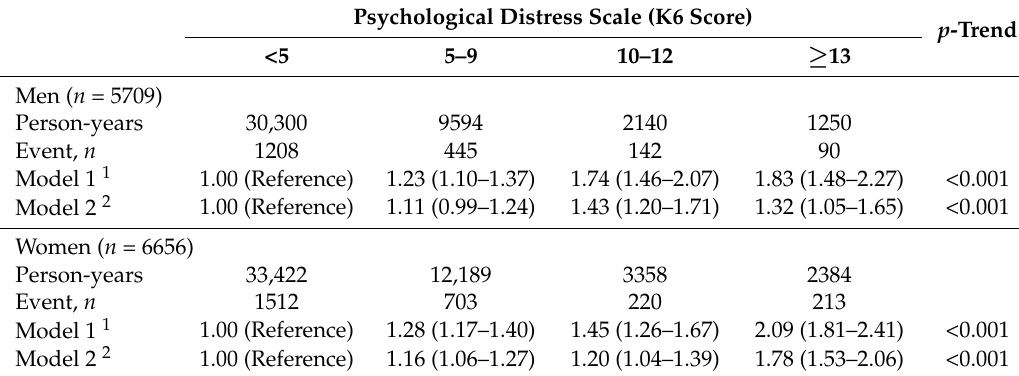
Table 3. Association between K6 score and incident functional disability stratified by